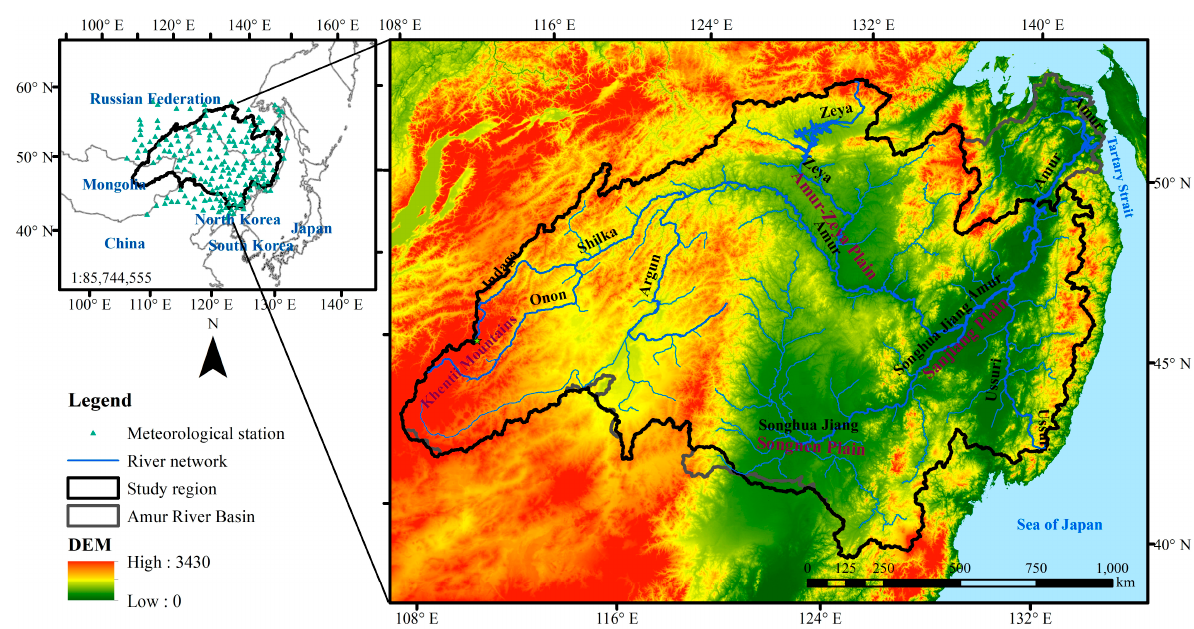
Figure 1. Geographic map showing the location of the Amur River Basin in Eurasia with the topographic information attached and the locations of 193 meteorological stations used for this study.